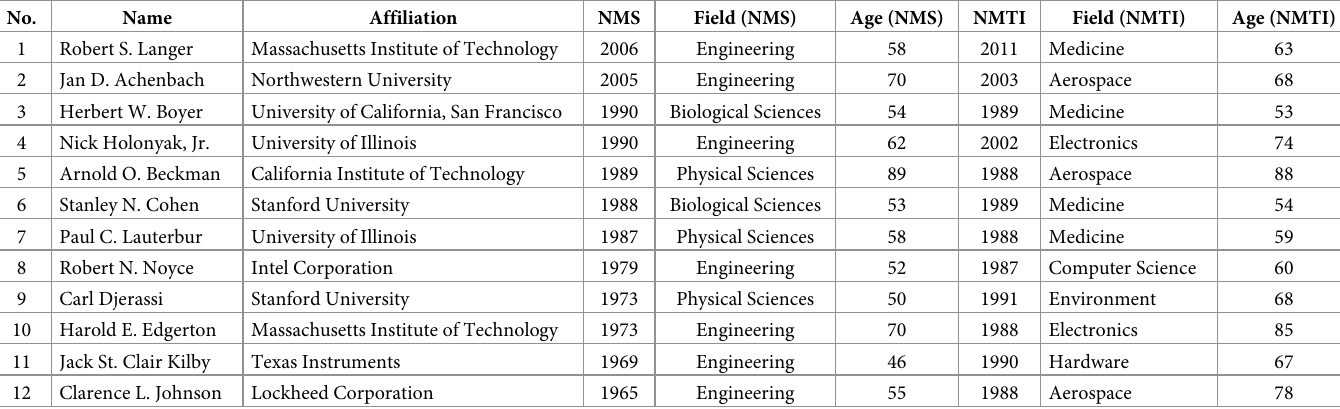
Table 1. Ages and institutions of the 12 scientists who received an NMS and